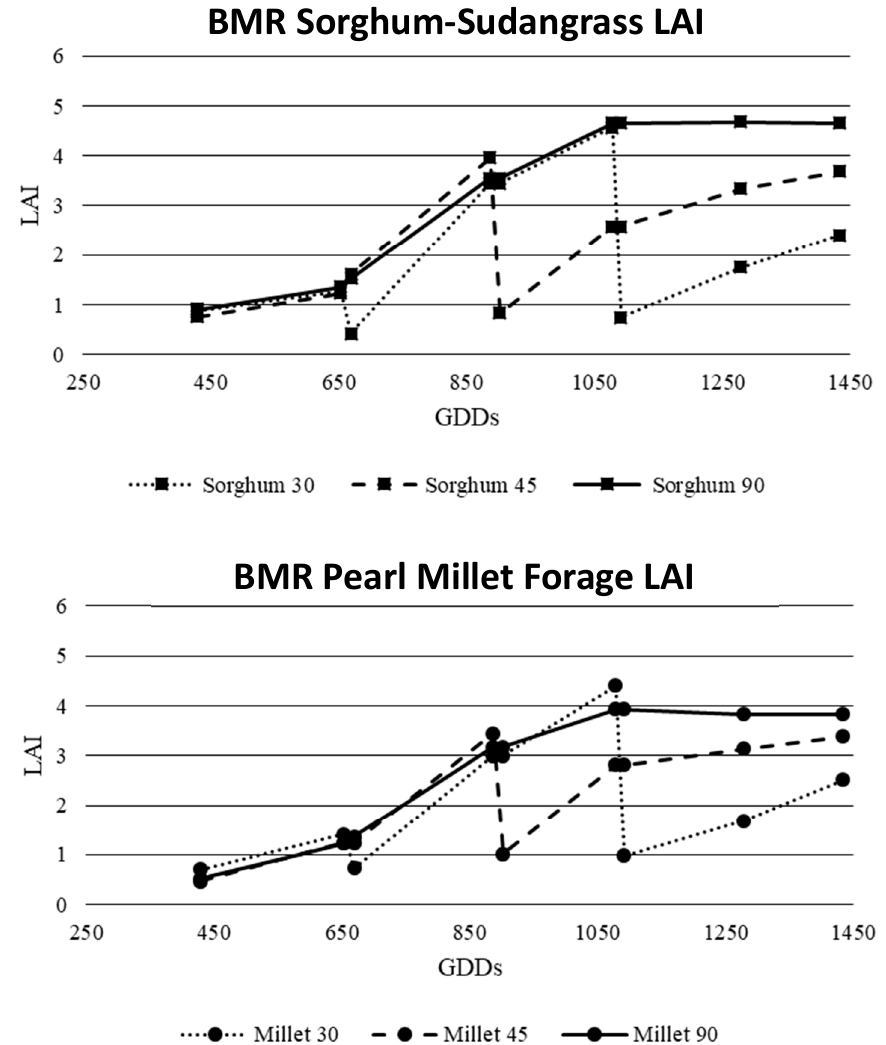
Figure 2. Brown midrib (BMR) sorghum-sudangrass and BMR pearl millet leaf area index (LAI) for three different harvest intervals (three 30-d, two 45-d, and one 90-d) in 2016 at Canyon, TX, USA.